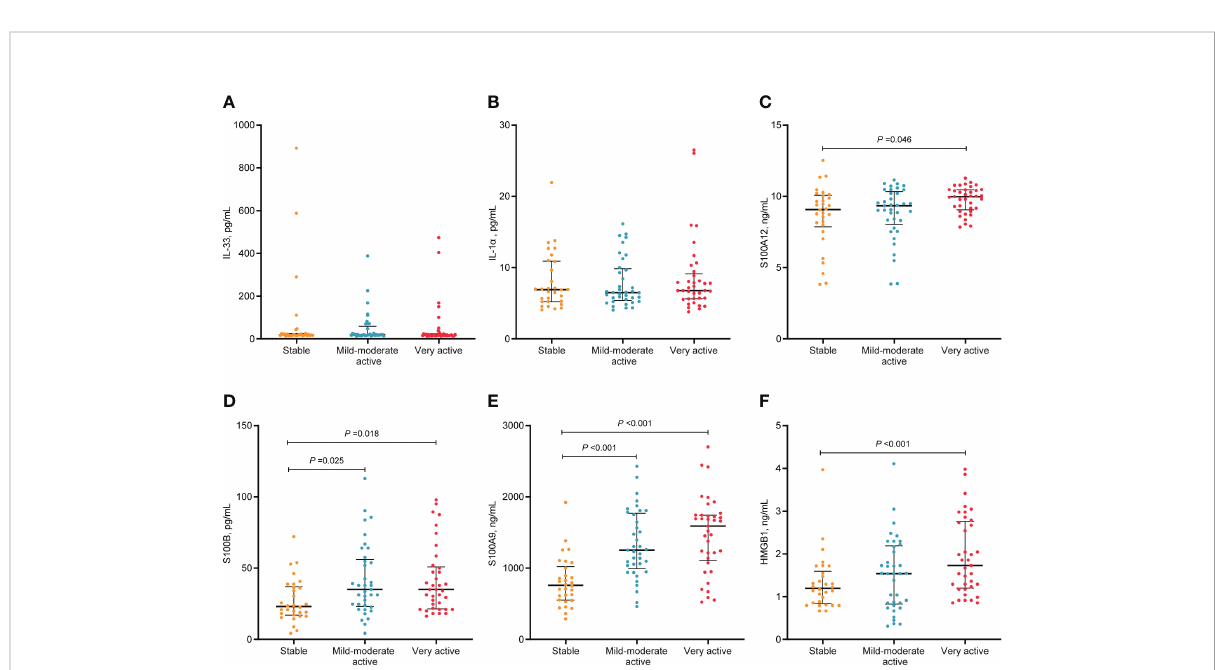
FIGURE 2 Serum levels of alarmins in different activity stage in patients with NSV. The median and IQR were represented by the middle black line, and the lower and upper black lines, respectively. Serum levels of IL-33 (A) , IL- a (B) , S100A12 (C) , S100B (D) , S100A9 (E) , HMGB1 (F) in patients with NSV at stable, mild-moderate active, and very active stage.